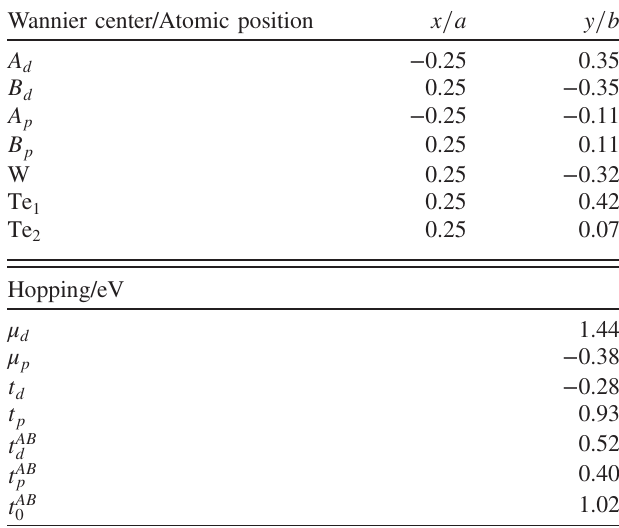
TABLE III. Wannier function centers and atomic positions for WTe 2 (left). Hopping parameters obtained from the Wannier interpolation (right). The positions are given in units of the lattice vectors (the origin is the center of inversion), while the hopping parameters are given in